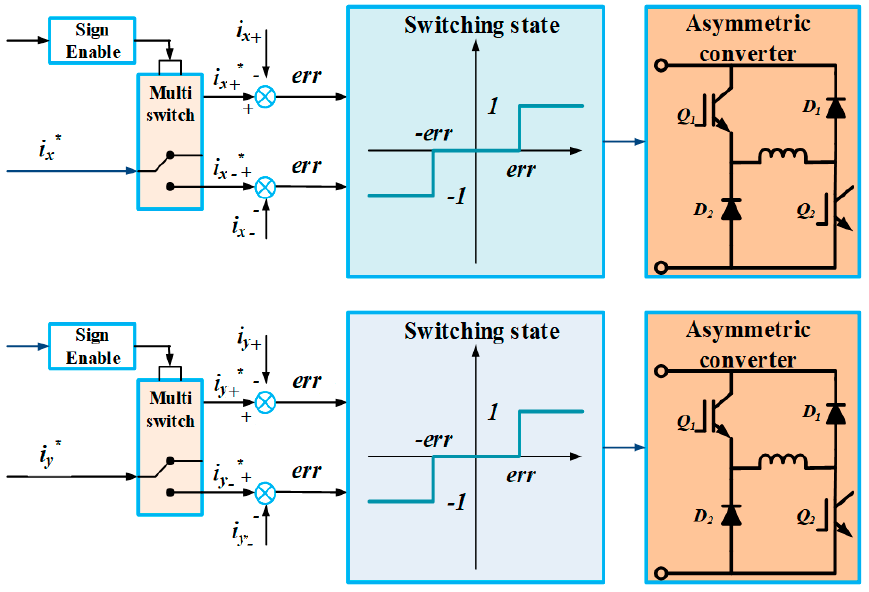
Table 2. Switch numbers for the 12/14 bearingless switched reluctance motor (BSRM).